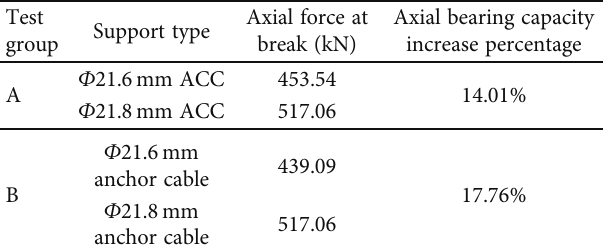
Figure 15: Comparison of axial force di ff erence of anchor cable structure. Table 5: A comparison of the axial bearing performance of supporting